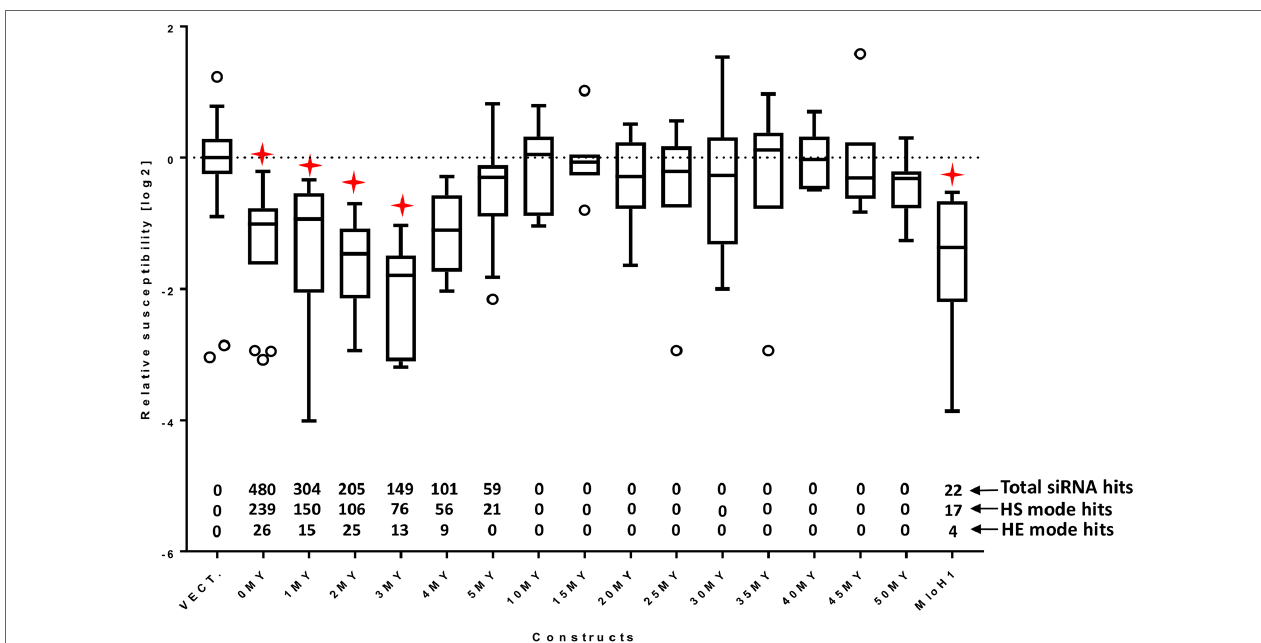
FIGURE 3 | RNAi effect of the HvMlo and derived “molecular clock” constructs (see Table 1 ) and the HvMloH1 construct as relative susceptibility index (RSI). The number of siRNA hits (total, high-sensitivity selection mode, and high-efficiency selection mode) is indicated above the x-axis. All RSI values are normalized to the empty vector control (VECT.) for the corresponding experiment and log 2 transformed. Lower values indicate stronger effect (decreased susceptibility of f.sp. hordei against bgh ). The boxes extend from the 25th to the 75th percentiles; the whiskers and outliers are calculated according to Tukey by GraphPad Prism (GraphPad Software, La Jolla CA) v. 7.00. Red stars indicate adjusted p-values (Dunnett’s multiple comparison test) < 0.05 in one-way ANOVA of each construct vs. empty vector control.